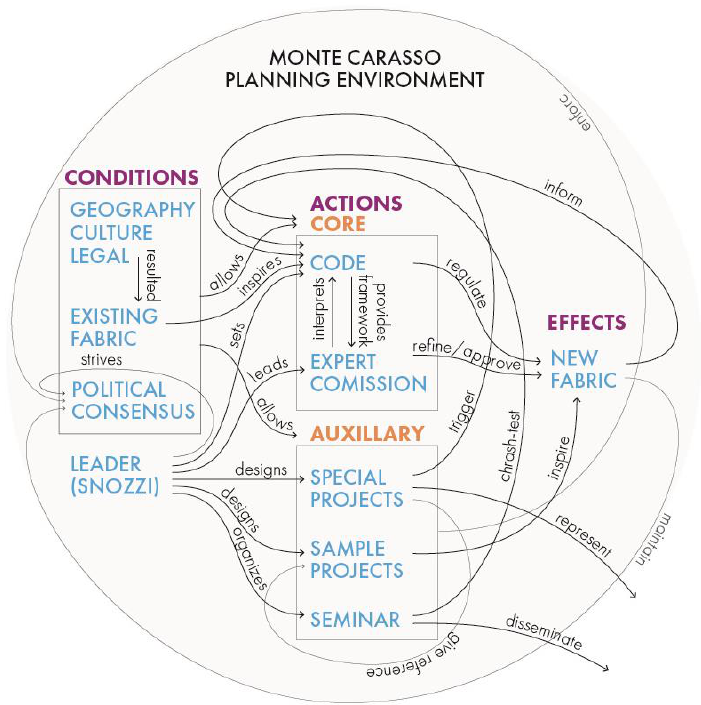
Figure 8. Mechanism of the Monte Carasso spatial regulatory environment with the sequence of elements. Source: Author.